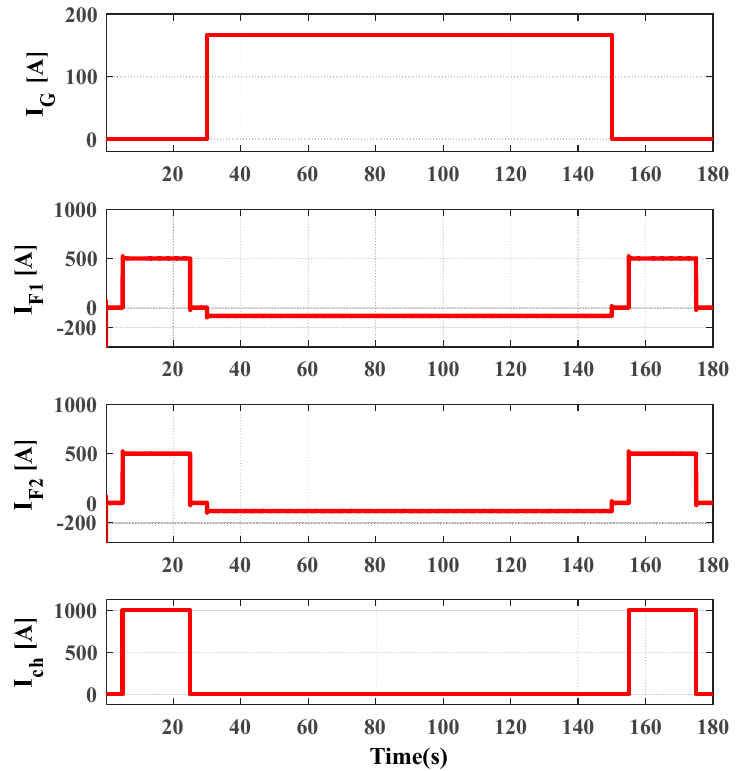
Figure 16. Simulation results for the electric current of the grid, FES1, FES2, and charger.